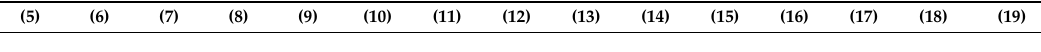
Table 3. Spearman correlation analysis among research variables ( n =